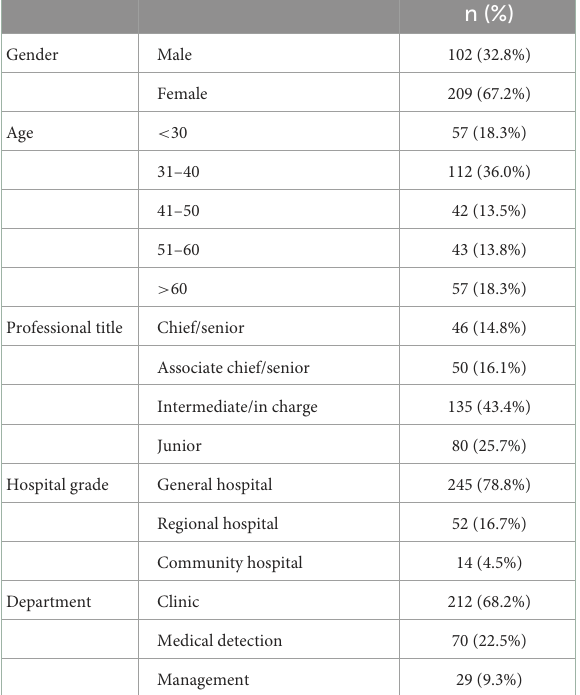
TABLE 1 Demographic